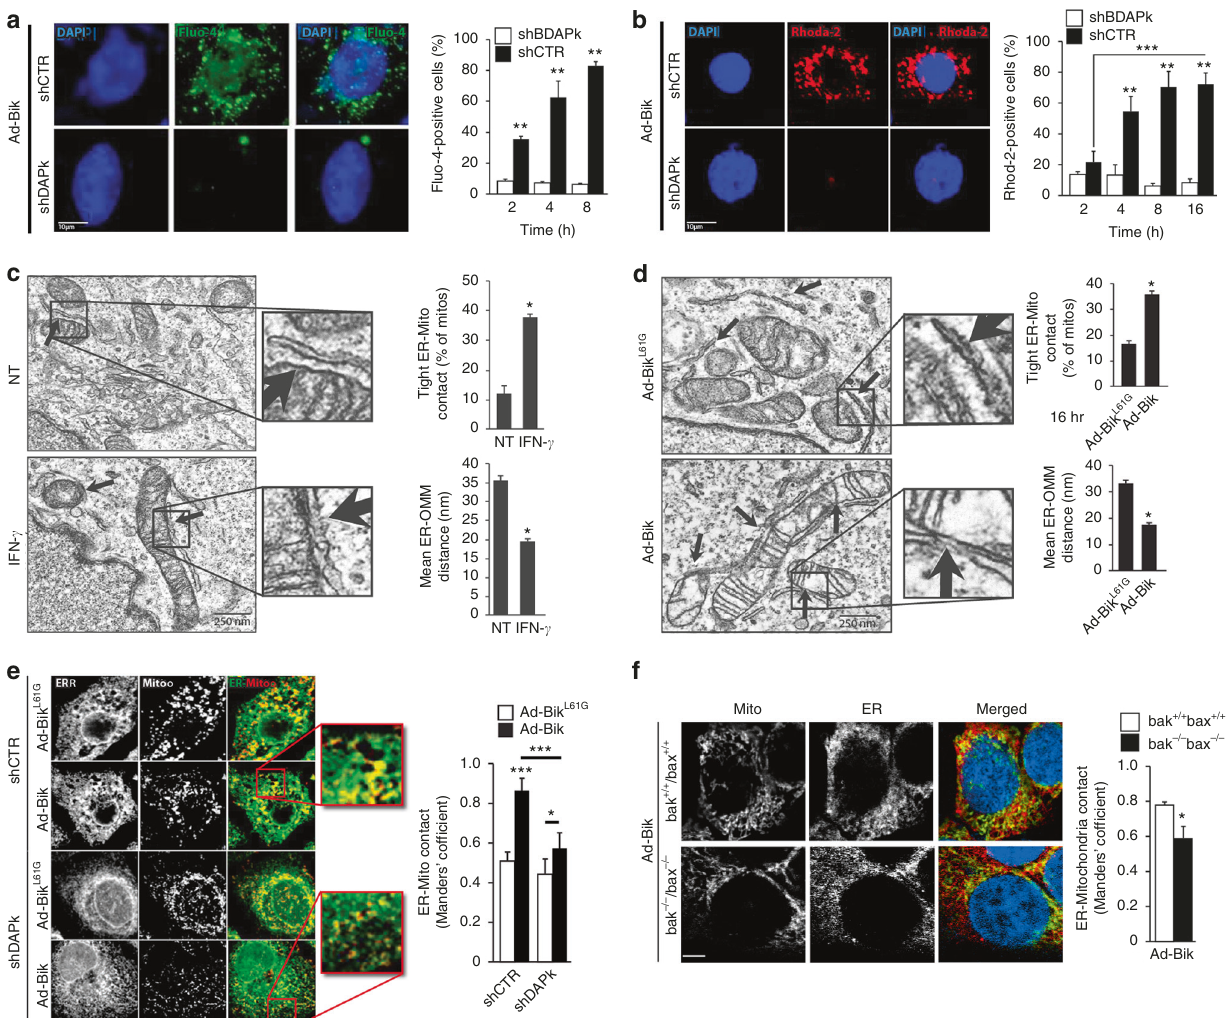
Fig. 4 Bik facilitates ER Ca 2+ release and enhances through DAPk1 the proximity of ER and mitochondria. HAECs stably expressing shCtr or shDAPk1 were infected with Ad-Bik and at the indicated time points fi xed and stained with Ca 2+ - fl ux indicator, Fluo-4 (green) ( a ) or with [Ca 2+ ] m indicator, Rhod-2 (red) ( b ) and counterstained for nuclei with DAPI (blue). The percentage of cells positive for Fluo-4 or Rhod-2 were quanti fi ed. Graphs show mean ± SEM of quanti fi ed cells. c , d Transmission electron microscopy of HAECs treated with medium alone or 50 ng/ml IFN- γ ( c ) or infected with 100 MOI Ad-Bik or Ad- Bik L61G ( d ) for 16 h. The bar graphs show the mean ER-OMM distances and the percentage of mitochondria with tight contact with the ER. White arrows show contact sites of ER and mitochondria. e Representative micrographs of HAECs stably expressing shCtr and shDAPk1, and infected with 100 MOI Ad- Bik or Ad-Bik L61G . Cells were stained with anti-CoxIV for mitochondria (green), with anti-calnexin for ER (red), and with DAPI for nuclei staining (blue). f bak + / + /bax + / + and bak − / − /bax − / − HCT116 cell lines were infected with 100 MOI Ad-Bik and 16 h later cells were stained with anti-CoxIV for mitochondria (green), with anti-calnexin for ER (red), and with DAPI for nuclei staining (blue). Confocal images of 3D reconstructions of ER and mitochondria were acquired. Scale bars, 5 μ m. ER-mitochondria contacts were quanti fi ed by Manders ’ coef fi cient, means and SEM ( n = 5, at least 40 cells per experiment) of the morphometric data. Differences between two groups were assessed for signi fi cance by Student ’ s t test. ANOVA was used to perform pair-wise comparison of the data from more than two groups followed by Fisher least signi fi cant difference test. Error bars indicate ± SEM, ( n = 5, with > 200 cells analyzed per condition); * = P < 0.05, ** = P < 0.01